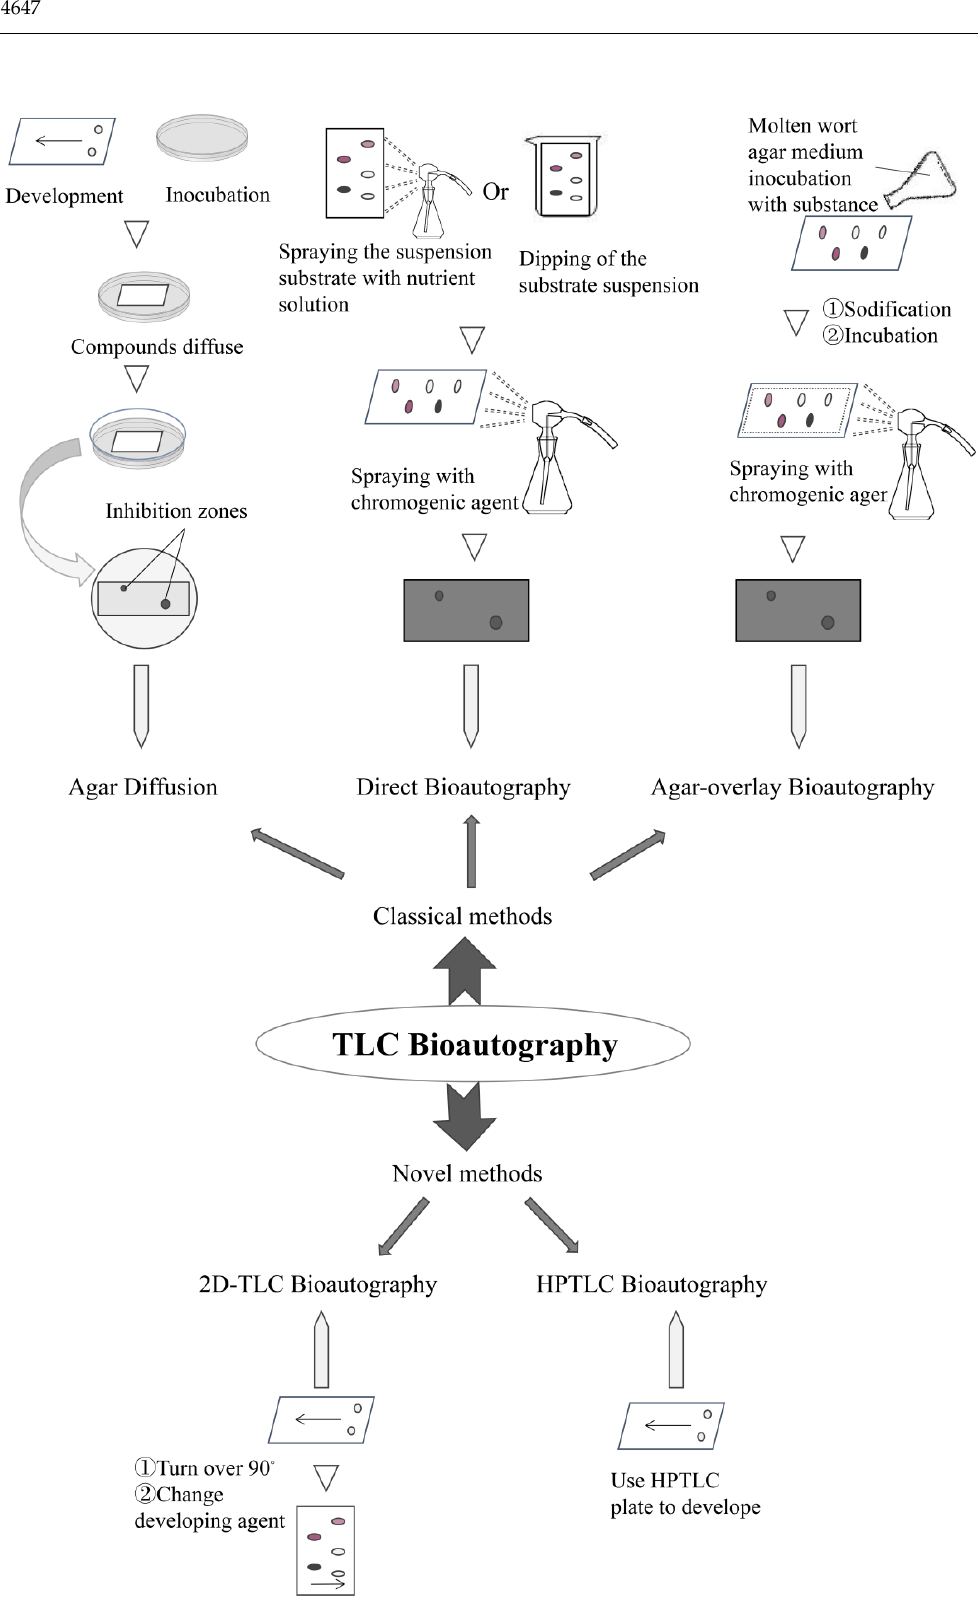
Figure 2. Scheme of different bioautography methods coupled with TLC. This figure introduces the main methods of TLC bioautographies and their simple operation processes. TLC bioautography is divided into two classical and novel categories. Based on the classical method, the novel methods add modern detection techniques improving the accuracy and specificity. In the agar diffusion method, the compounds transfer from the thin layer to the medium. Direct bioautography and agar overlay bioautography are detected directly on the thin layer, but there is a difference in the production of medium